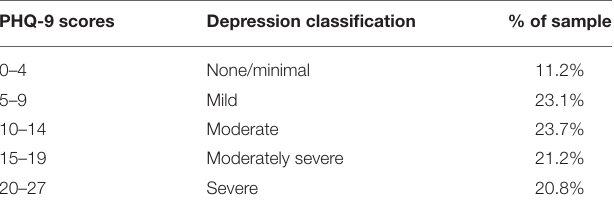
TABLE 2 | Distribution of PHQ-9 depression items and depression classifications ( n =